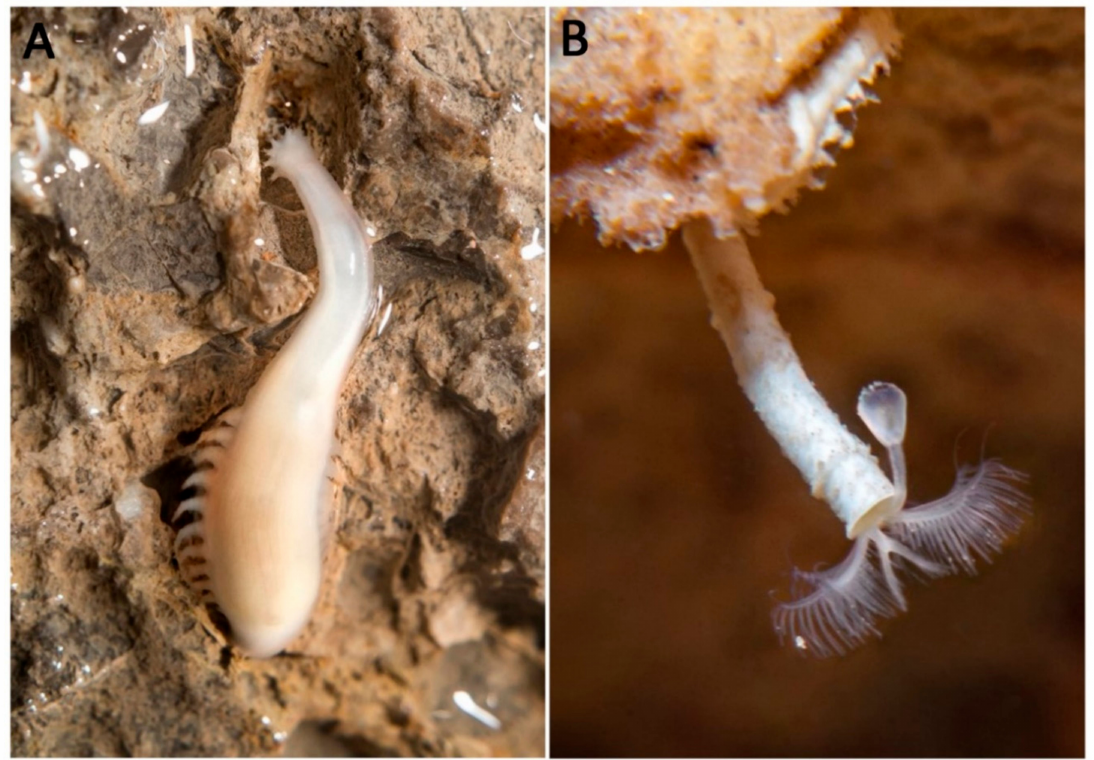
Figure 5. Two examples of subterranean annelids. ( A ) The leech Croatobranchus mestrovim lives in deep shaft-like caves in the Velebit karst area in Croatia. It has been recorded as deep as 1320 m below the surface, and it walks around on the cave walls with leg-like appendages. ( B ) The serpulid polychaete Marifugia cavatica attaches its calcareous tube to the walls of freshwater caves found on the eastern Adriatic coast and further inland; it is eyeless and lacks pigmentation. Photographs: Jana Bedek, archive of the Croatian Biospeleological